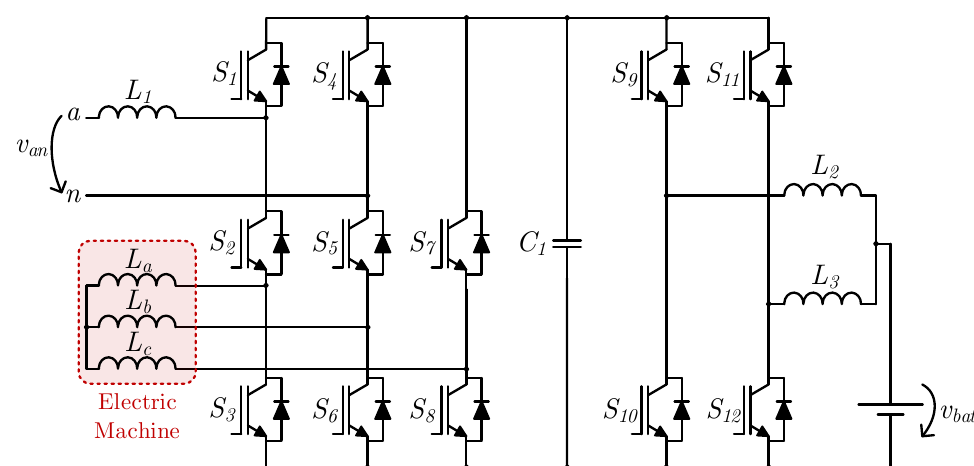
Figure 5. EV IBC proposed by O. Hegazy et al. in 2013 [17].